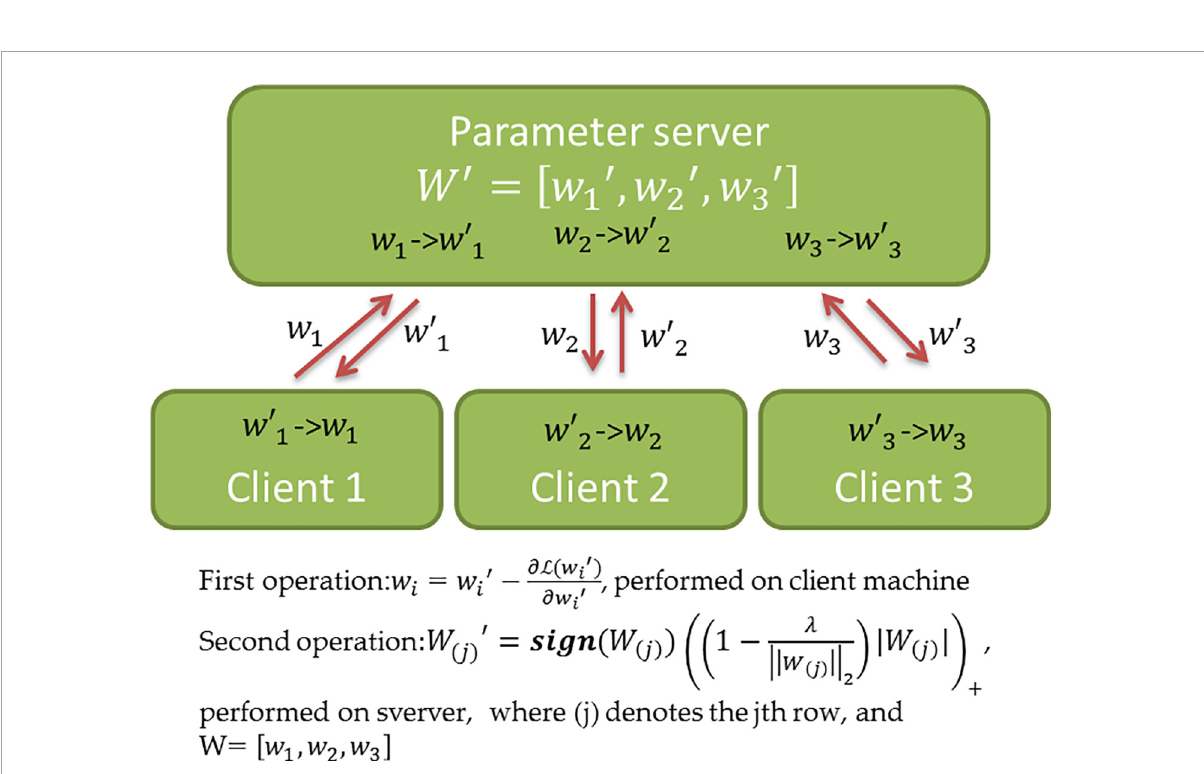
FIGURE4 Schematic overview of distributed MTL. The Figure shows the distributed computations and parameter exchange of the MTL method with joint predictor selection (see Supplementary Table 1 for details). Once the algorithm starts, the client i performs a one-iteration gradient descent and transfers the result w i to the server. After the server collected messages from all clients, the second operation is performed, and the updated w (cid:48) i is returned to client i . This procedure is repeated until the convergence of the solution ( W (cid:48) ≈ W